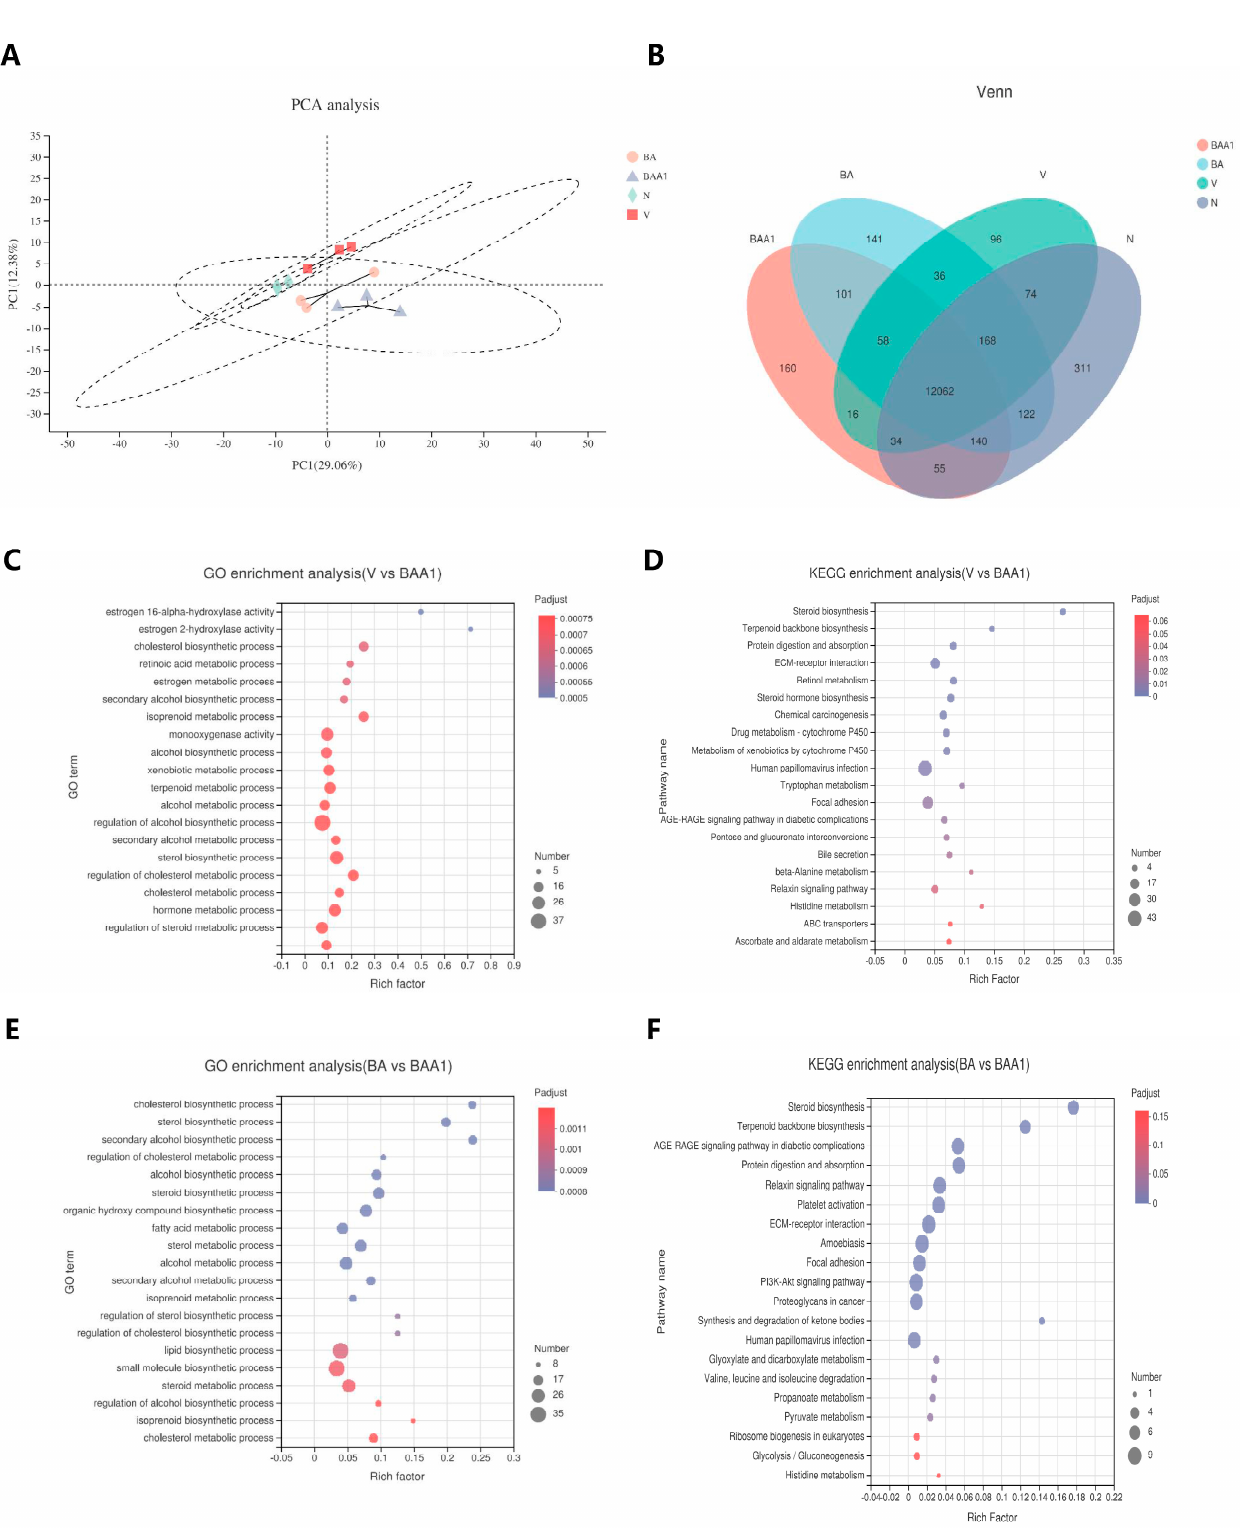
Figure 7. Transcriptomics analysis of BA- and BAA1-treated cells. pHBV1.2-transfected HepG2 cells were treated with 50 µ M of BA or BAA1 for 4 days and subjected to transcriptomics analysis. ( A ) PCA analysis, ( B ) Venn analysis, and ( C , D ) GO and KEGG enrichment analyses between V and BAA1. ( E , F ) GO and KEGG enrichment analyses between BA and BAA1. The transcriptomics data were analyzed on the free online platform (www.majorbio.com, accessed on 28 February 2022).